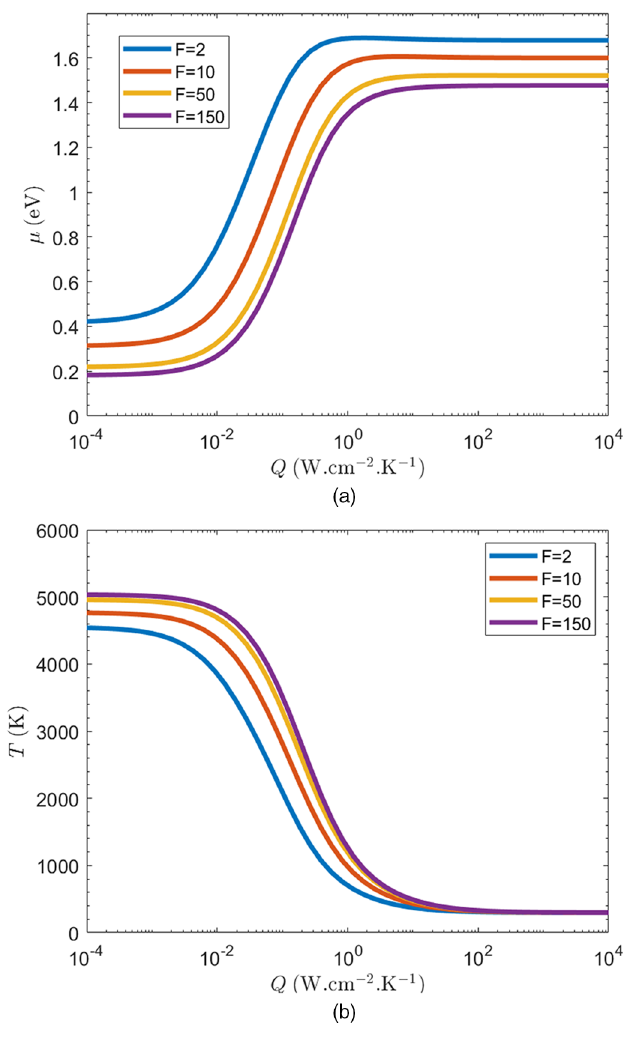
Fig. 2. (a) Chemical potential and (b) temperature of the carriers in open-circuit condition as a function of the thermaliza- tion coef fi cient Q , for different absorption